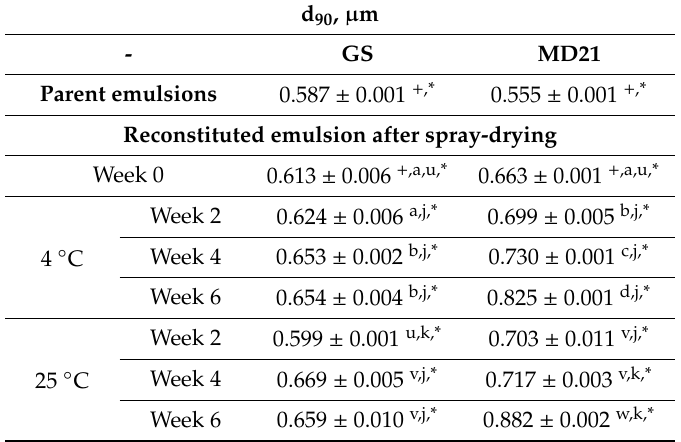
Table 1. Oil droplet size distribution (ODSD) of fresh and reconstituted emulsions during storage time at 4 and 25 ◦ C.